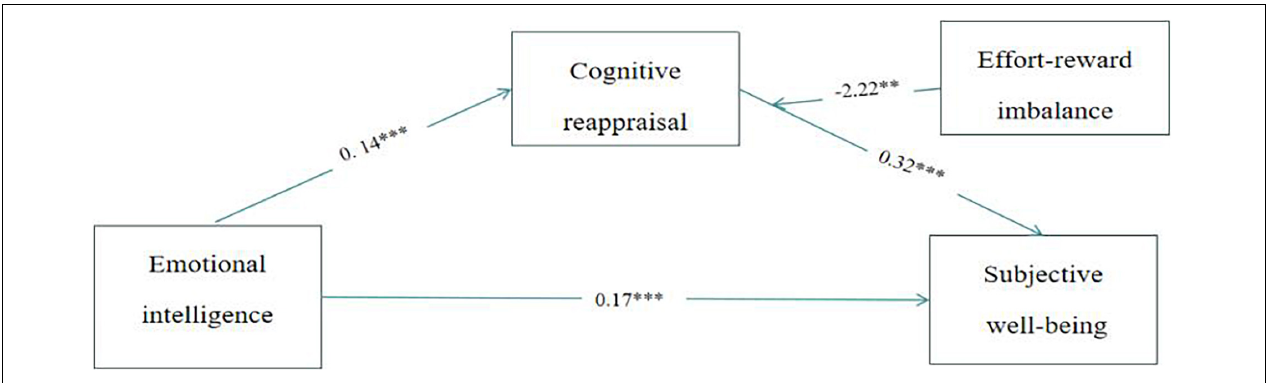
FIGURE 2 | The moderation mediate effect. ** p < 0.01; *** p <